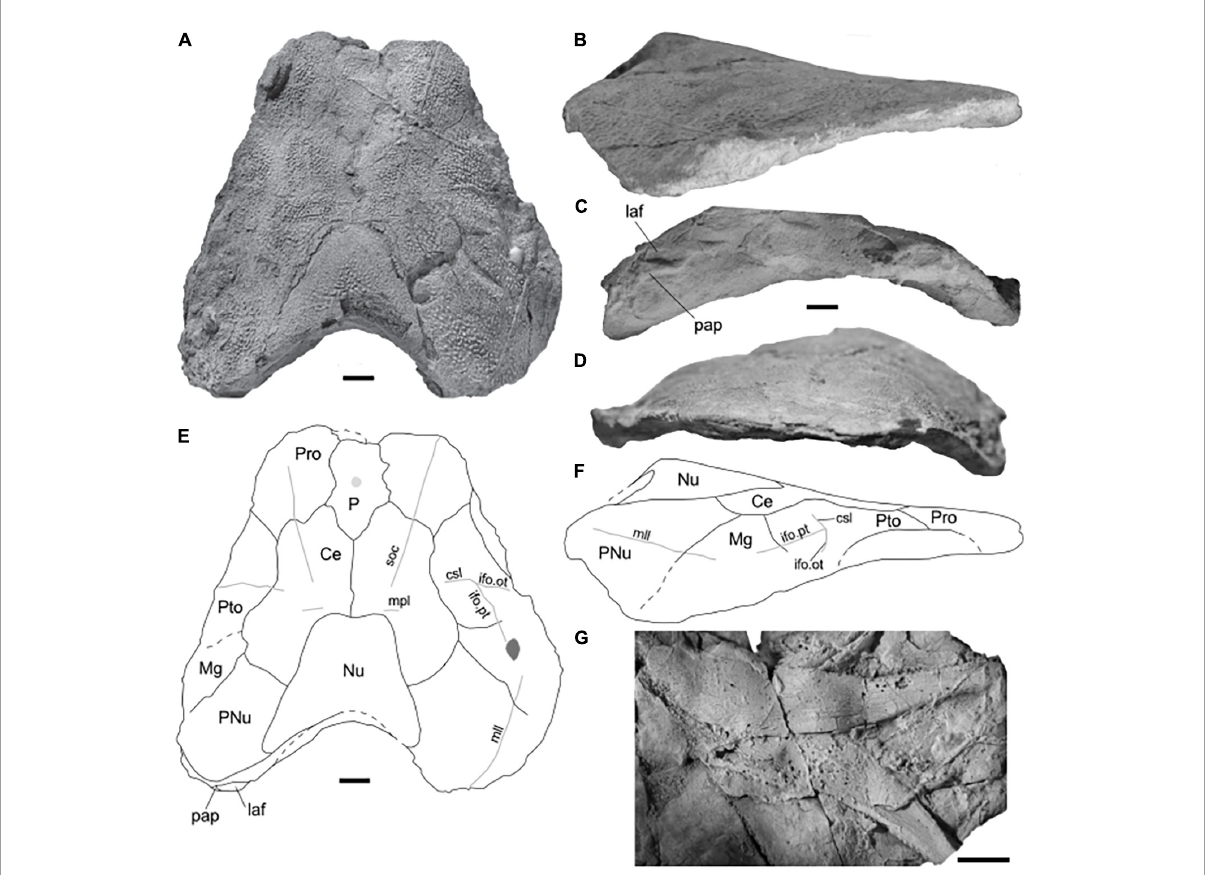
FIGURE3 Skull roof and lower jaw of Amazichthys trinajsticae gen. et sp. nov. (A–F) PIMUZ A/I 5141 in dorsal (A) , lateral (B) , posterior (C) , and frontal view (D) . Line drawing of dorsal (E) and lateral-view (F) . (G) Nearly complete lower jaws from AA.MEM.DS.9 (G) . Scale bars correspond to 10 mm. Ce, central plate; csl, central sensory line canal; ifo.ot, otic branch of the infraorbital sensory line canal; ifo.pt, postorbital branch of the infraorbital sensory line canal; laf, lateral articular fossa; Mg, marginal plate; mll, main lateral line canal; mpl, middle pit line; Nu, nuchal plate; P, pineal plate; pap, para articular process; PNu, paranuchal plate; Pro, preorbital plate; Pto, postorbital